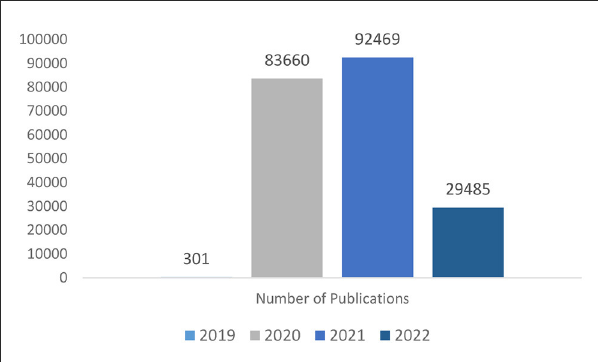
FIGURE1 Year-wise number of publications listed in CORD-19 dataset.